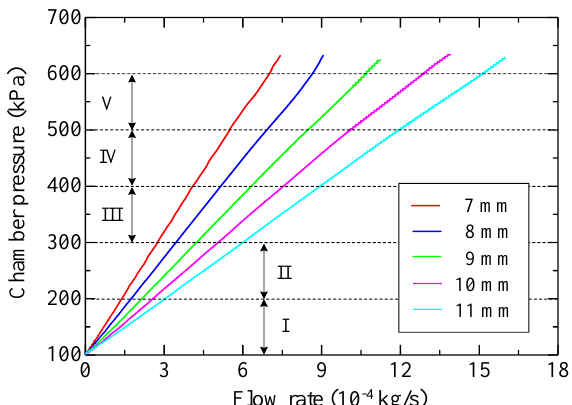
Figure 10. Pressure in the chamber versus mass flow rate obtained by the discharge method for the five porous media of group 2.